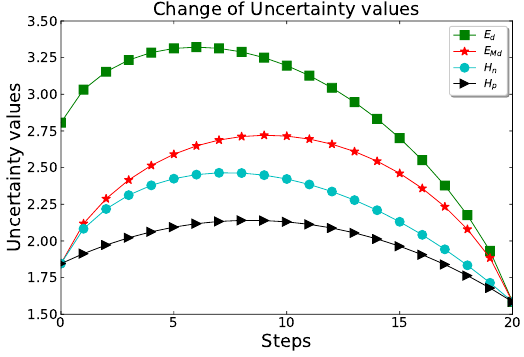
Figure 3. The change of uncertainty values in Example 6.